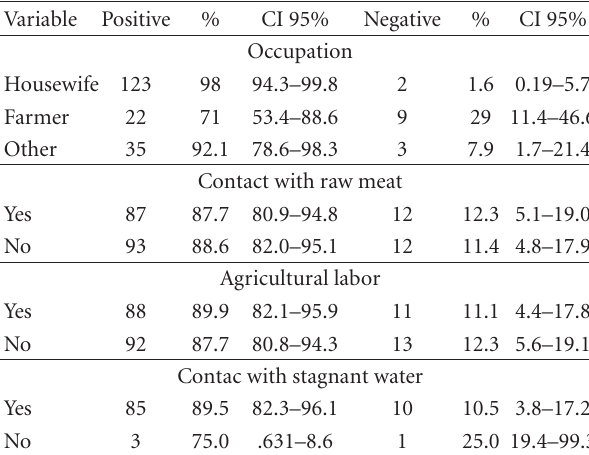
Table 2: Leptospirosis prevalence and occupational exposure.